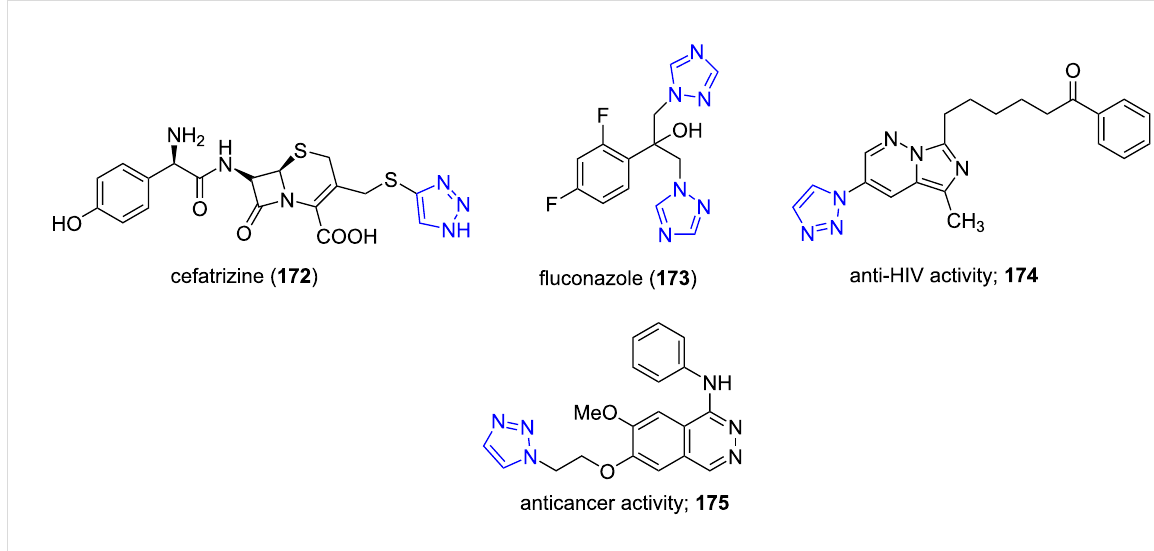
Figure 13: Triazoles-containing marketted drugs and pharmacologically active molecules.